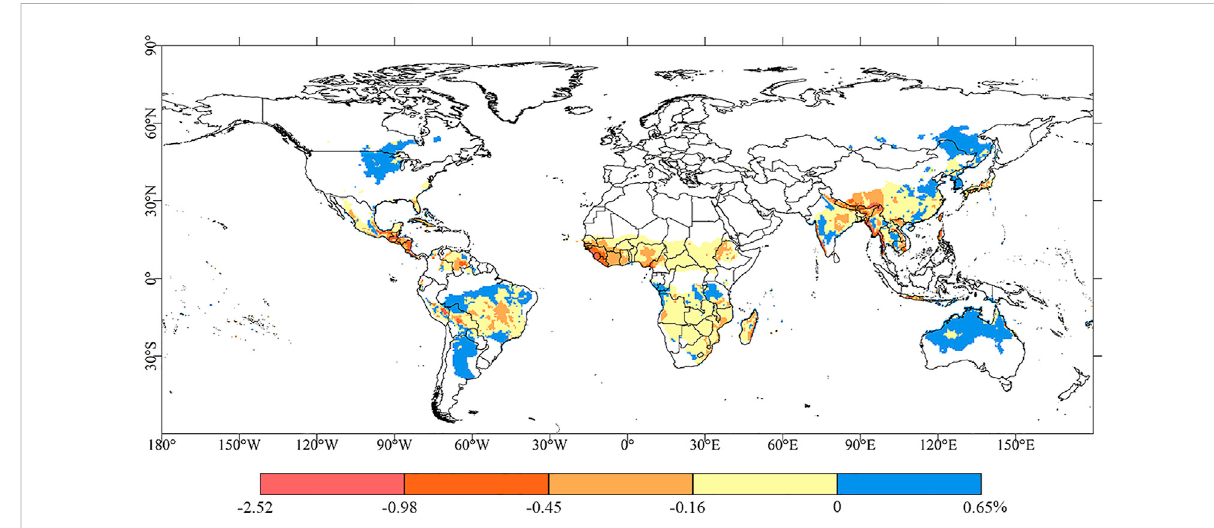
FIGURE 2 Calendaragesagainstprecipitationanomalies(mm/yr)formonsoonareaper10 ° sincethelast12,000 cal yearBP.Theuncertaintiesareplotted at the 2-sigma levels (gray bar), and the loess method fi ltered results are plotted in